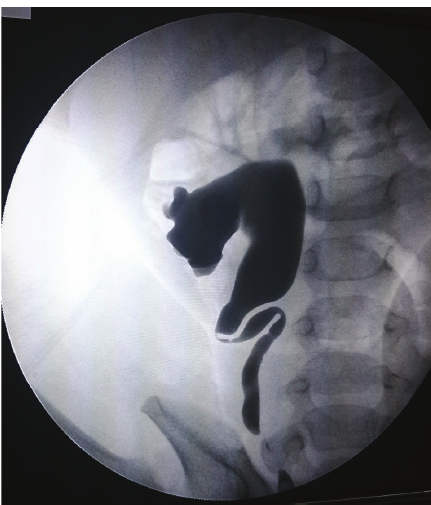
Figure 4: Retrograde pyelography demonstrating a midureteric stricture and proximal dilated ureter.